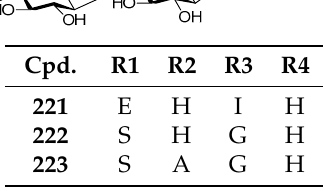
Figure 38. Structures of compounds 221 – 223 .